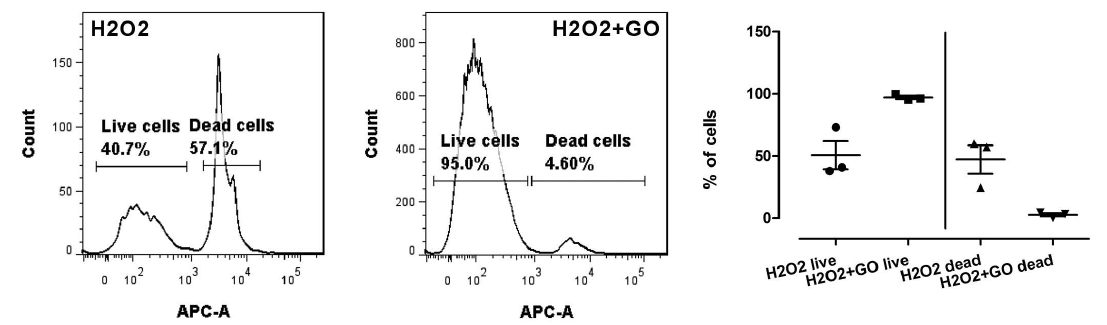
Figure 3. Effect of GO on cell viability measured by SYTOX Red Cell Dead assay. Statistical analysis was performed using the one-way ANOVA ( p < 0.05). H 2 O 2 denotes cells without GO treatment, exposed to H 2 O 2 ; H 2 O 2 +GO denotes cells treated with GO and exposed to H 2 O 2.